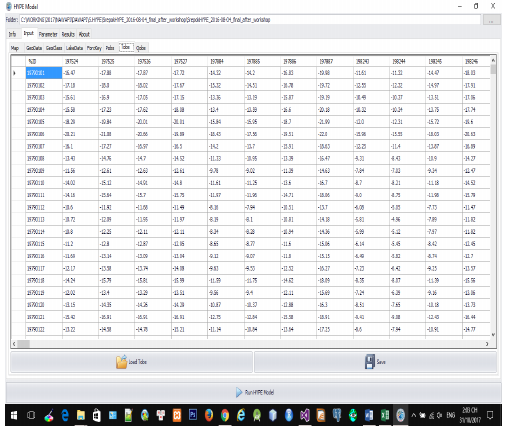
Fig. 5: The interface of entering rainfall, temperature and discharge data.